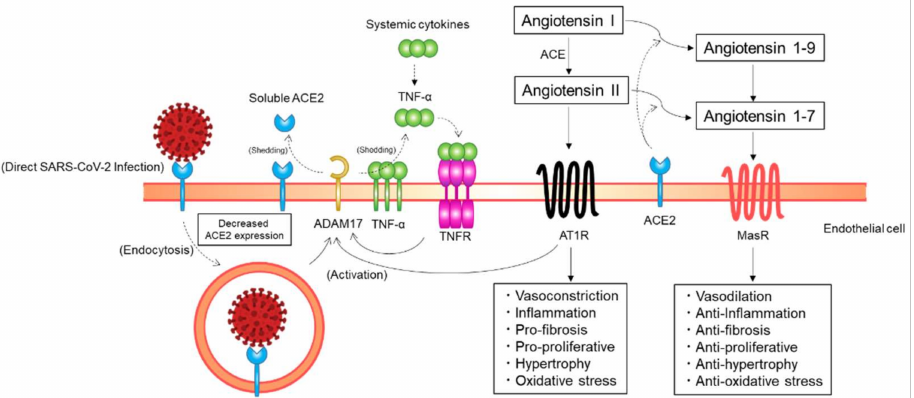
Figure 3. Putative mechanisms of a decrease in angiotensin-converting enzyme 2 (ACE2) expression on endothelial cells. ACE2 expression on endothelial cells may be downregulated through ACE2 endocytosis along with SARS-CoV-2 particles and ectodomain shedding of ACE2 by a disintegrin and metalloprotease 17 (ADAM17). AT1R, angiotensin II type 1 receptor; ACE, angiotensin-converting enzyme; MasR, Mas receptor; TNF, tumor necrosis factor; TNFR, TNF